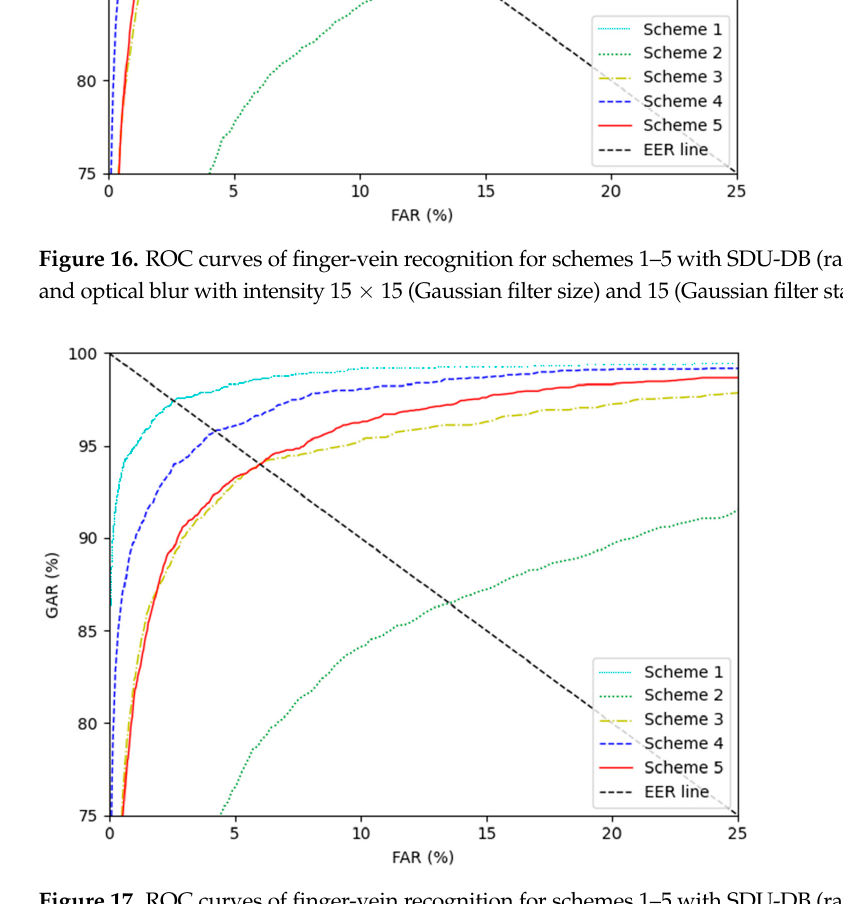
Figure 17. ROC curves of finger-vein recognition for schemes 1–5 with SDU-DB (random motion blur and optical blur with intensity 19 × 19 (Gaussian filter size) and 19 (Gaussian filter standard deviation)).